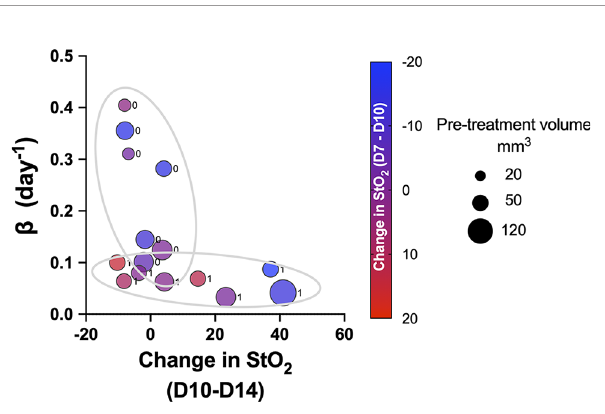
FIGURE 7 | Scatter bubble plot of change in StO 2 values between D10 and D14 vs. tumor growth rate b values. The change in StO 2 from D7 to D10 is indicated by the color bar where a decrease in oxygenation is represented by red, while an increase in oxygenation is represented by blue. The size of the bubbles is representative of the pretreatment volume of the tumors on D10. The label 0 indicates tumors in the control group, while 1 corresponds to